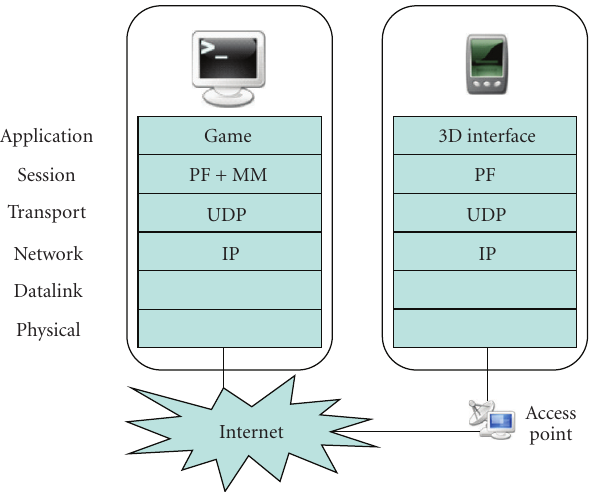
Figure 1: The playing session: a new layer in the communication protocol